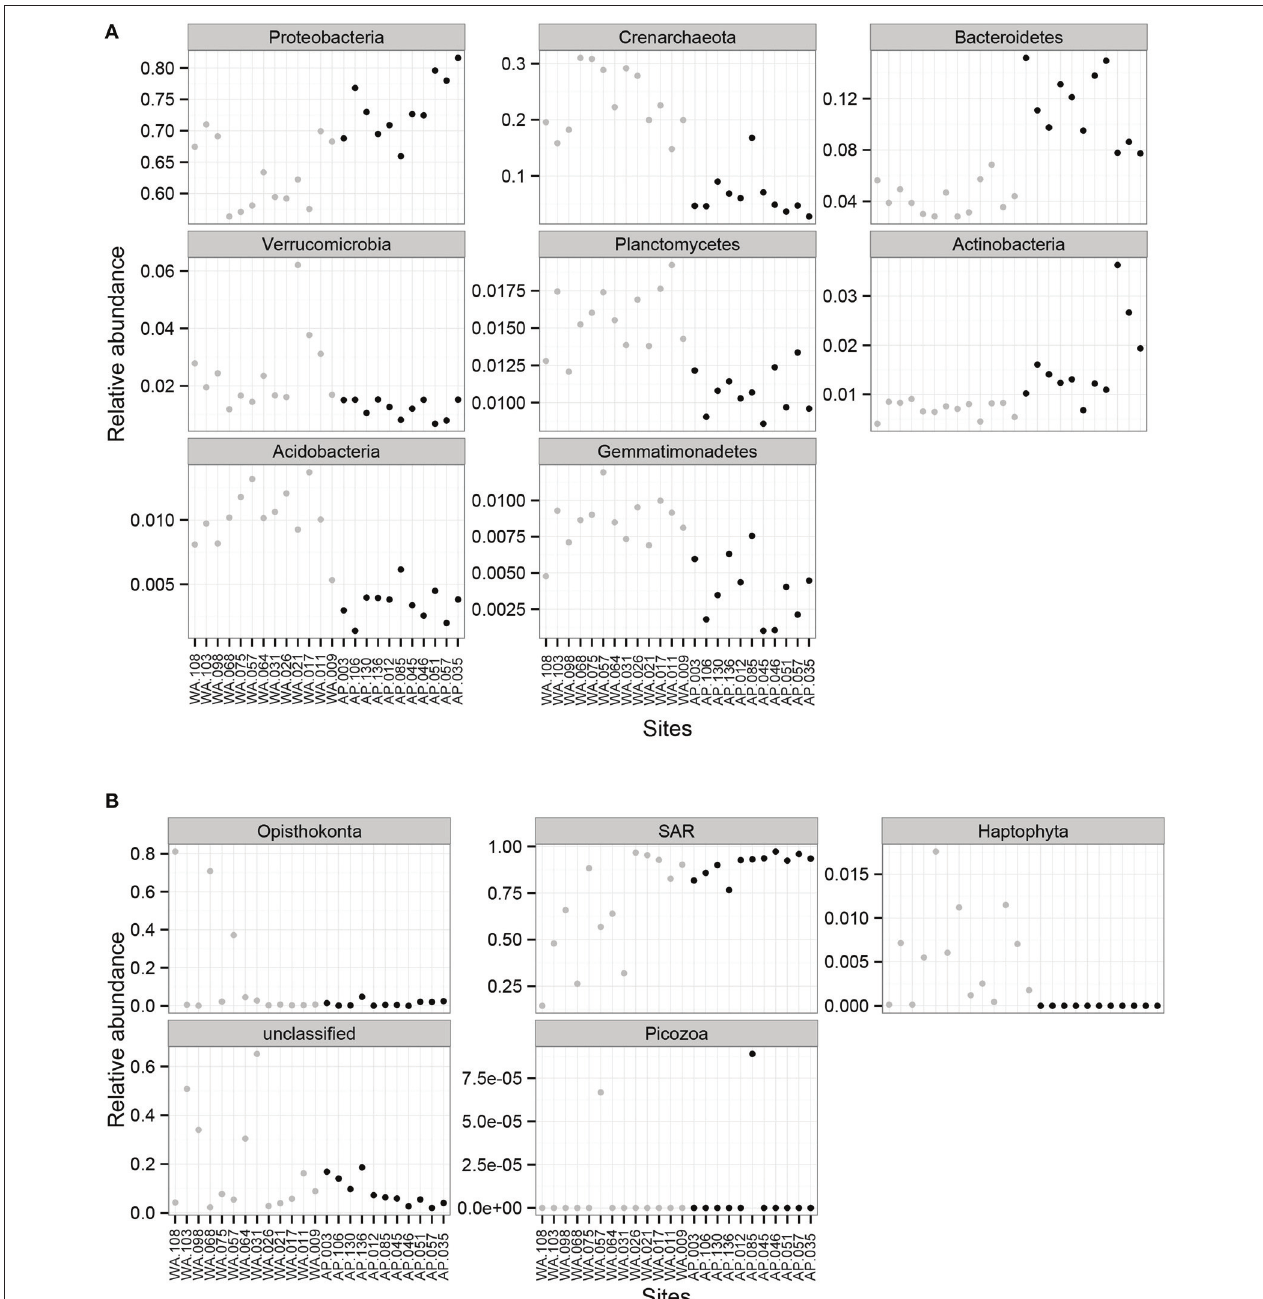
FIGURE 3 | Mean relative abundance of (A) 16S rRNA sequences based bacterial and archaeal phylum and (B) 18S rRNA sequences based on eukaryotic orders for Western Antarctica (WA, gray circles) and Antarctic Peninsula (AP, black